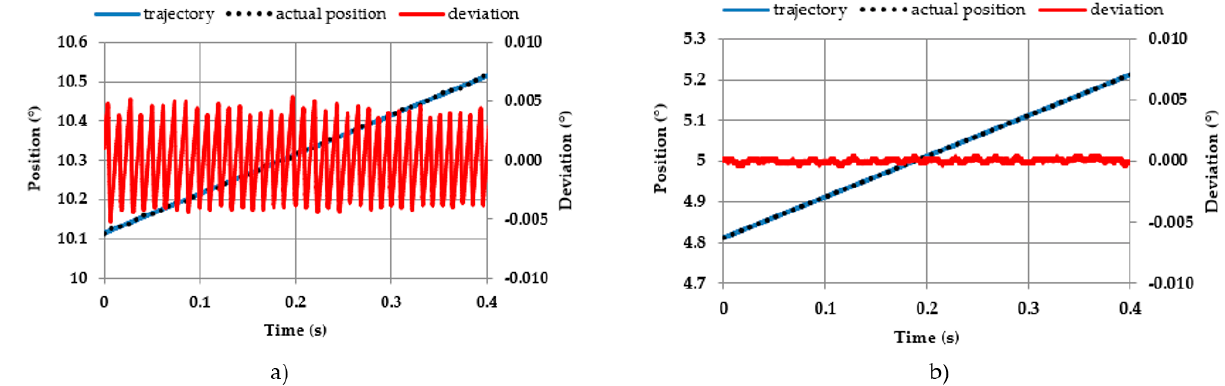
Figure 18. Response of constant velocity trajectory with the optimal PID parameters at 1.0 °/s with ( a ) single source driving and ( b ) DSDF driving.